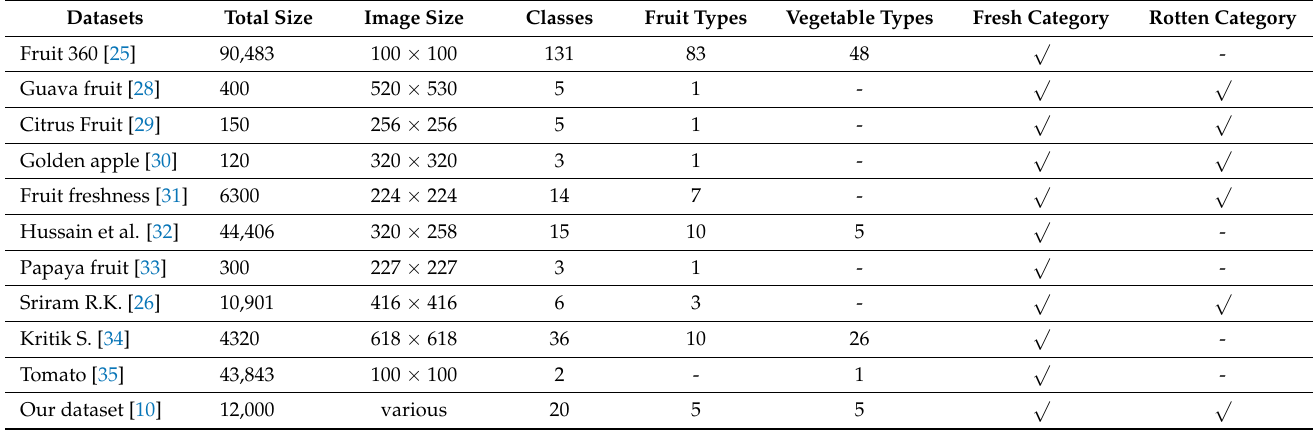
Table 2. The comparison of current fruit and vegetable dataset for fruit